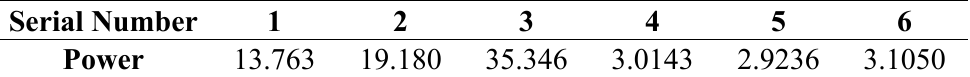
Table 2. Subsection power spectrum estimation of experimental signals ( × 10 4 ).